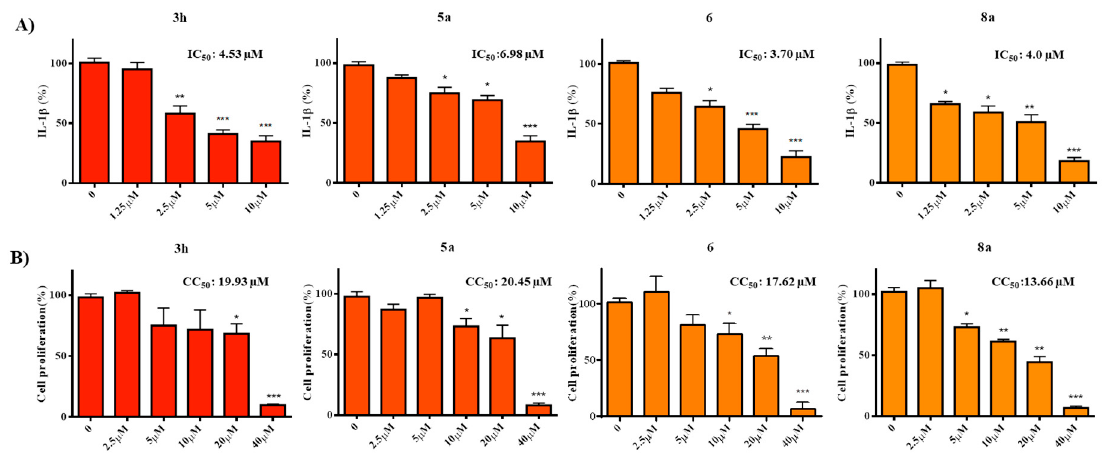
Figure 3. ( A ) Cellular proliferation assays of key compounds (5 μ M) in THP-1 for 24 h by MTT